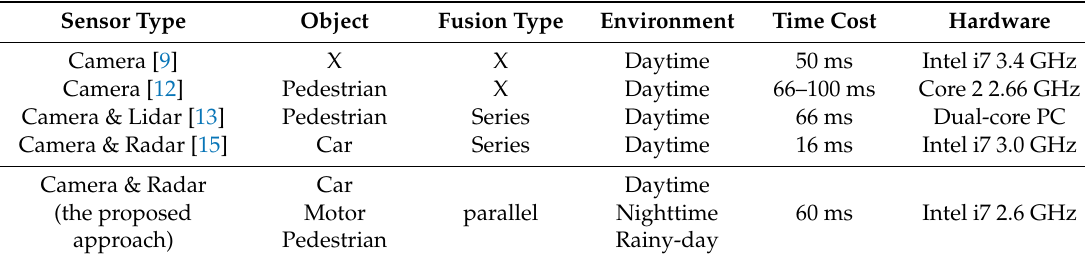
Table 6. Comparison with existing related